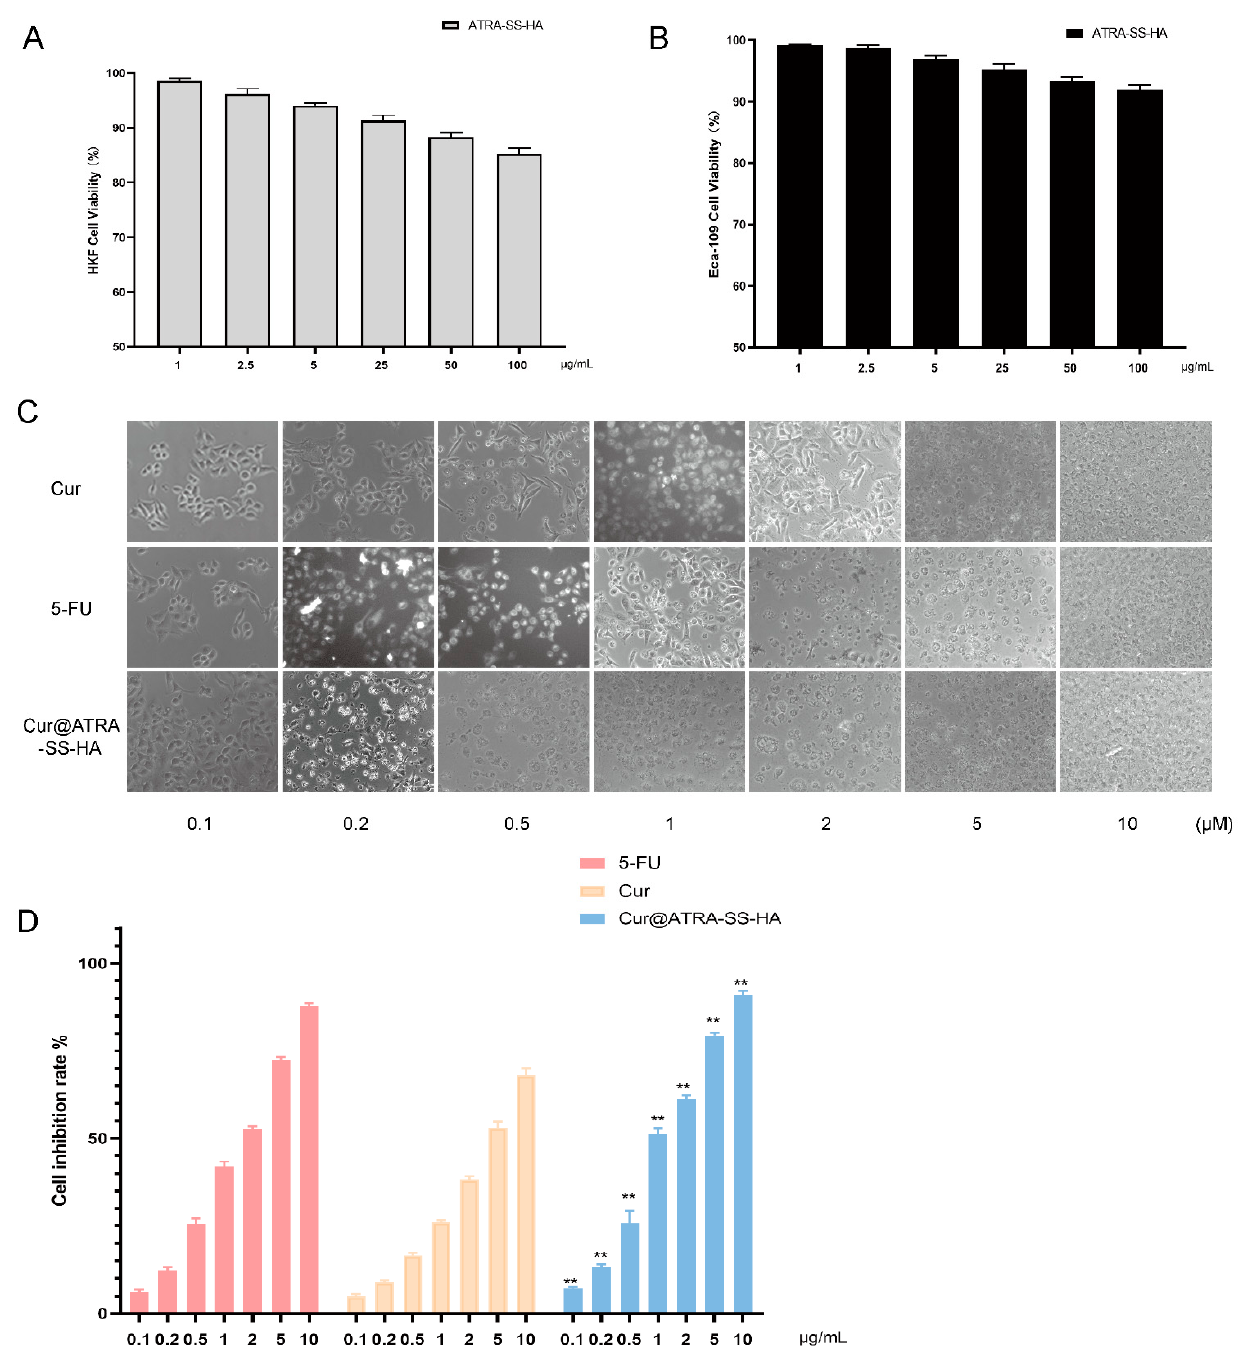
Figure 5. Relative cell viability of HKF cells ( A ) and Eca-109 cells ( B ) after incubation with ATRA-SS-HA at the concentration of 0, 2.5, 5, 10, 50, 100 μ g/mL for 24 h. Eca-109 cells were incubated with 5-FU, free curcumin and Cur@ATRA-SS-HA at the concentration of 0.1, 0.2, 0.5, 1, 2, 5, 10 μ g/mL for 24 h. Cell image and cell inhibition rate were shown in ( C , D ), respectively. **: p < 0.01, cell inhibition rate of Cur@ATRA-SS-HA group versus free curcumin group ( n = 3). Table 4. IC50 value of 5-FU, free curcumin, and Cur@ATRA-SS-HA.